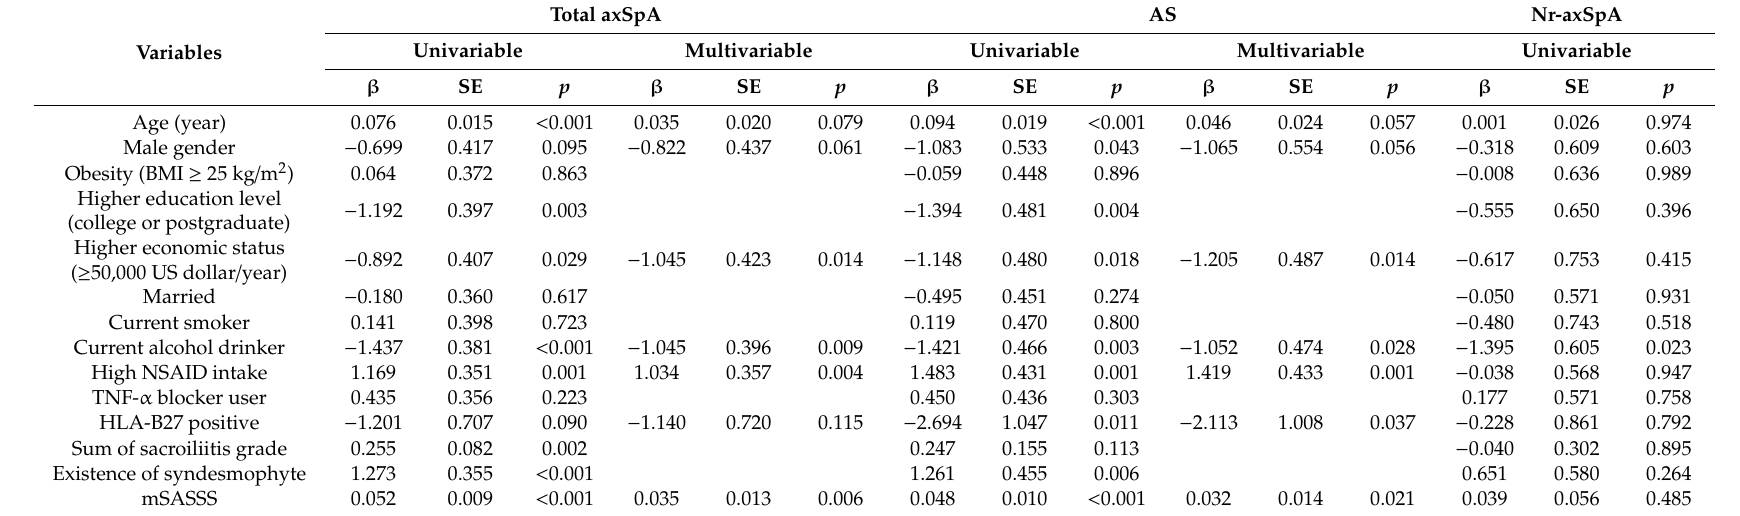
Table 4. Univariable and multivariable linear regression analysis of predicting ASAS HI in total axSpA, AS, and